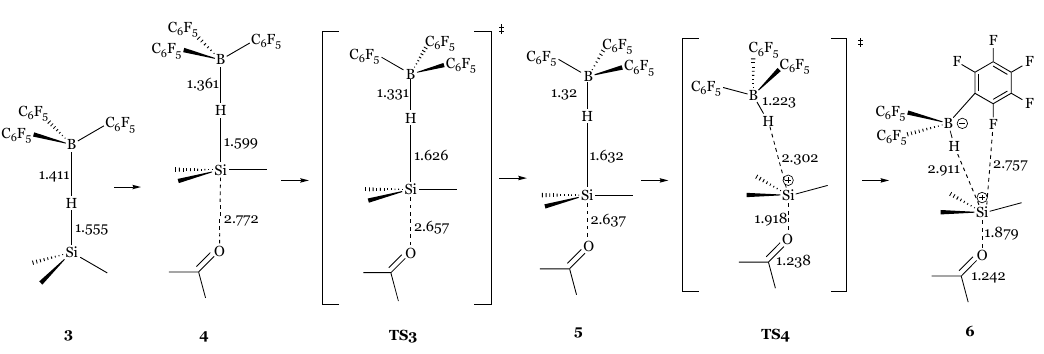
Figure 41. Intermediates and transition states of the silane-activation reduction mechanism.